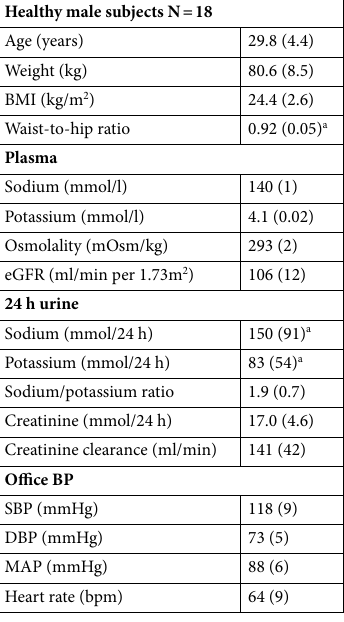
Table 1. Baseline characteristics at screening visit (before commencement of the diets). All values are expressed as mean (SD), unless marked otherwise. BP blood pressure, SBP systolic blood pressure, DBP diastolic blood pressure, MAP mean arterial pressure. a Values are expressed as median (interquartile